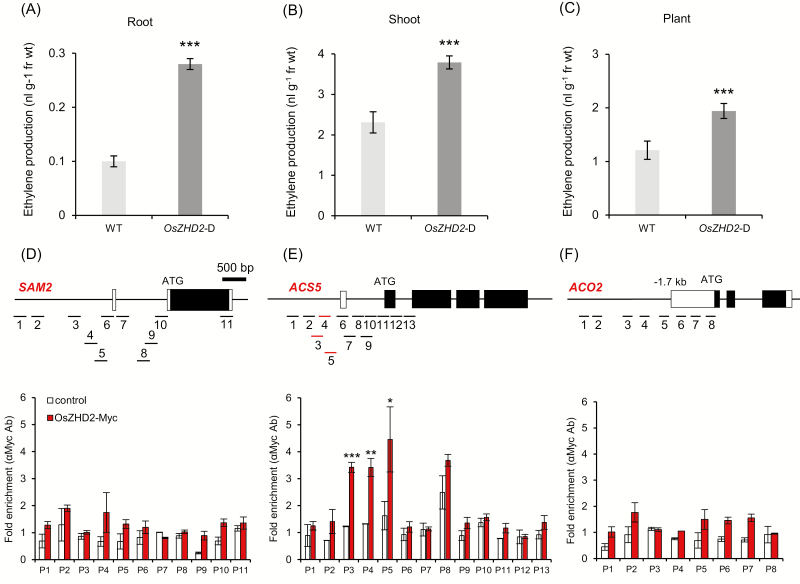
Analysis of ethylene accumulation and ChIP assay. (A–C) Ethylene production in roots (A), shoots (B), and whole plants (C) at 8 DAG. n=4. Error bars show the SD. Statistical significance is indicated by *** (P<0.001). (D–I) ChIP assay. Black and white boxes indicate exons and the untranslated region (UTR), respectively. OsZHD2-Myc enrichment in the chromatin regions of SAM2 (D), ACS5 (E), and ACO2 (F). Root samples were obtained from 8 DAG transgenic plants expressing OsZHD2-Myc (red bars) or Myc alone (open bars). Statistical significance is indicated by * (P<0.1), ** (P<0.05), and *** (P<0.01).